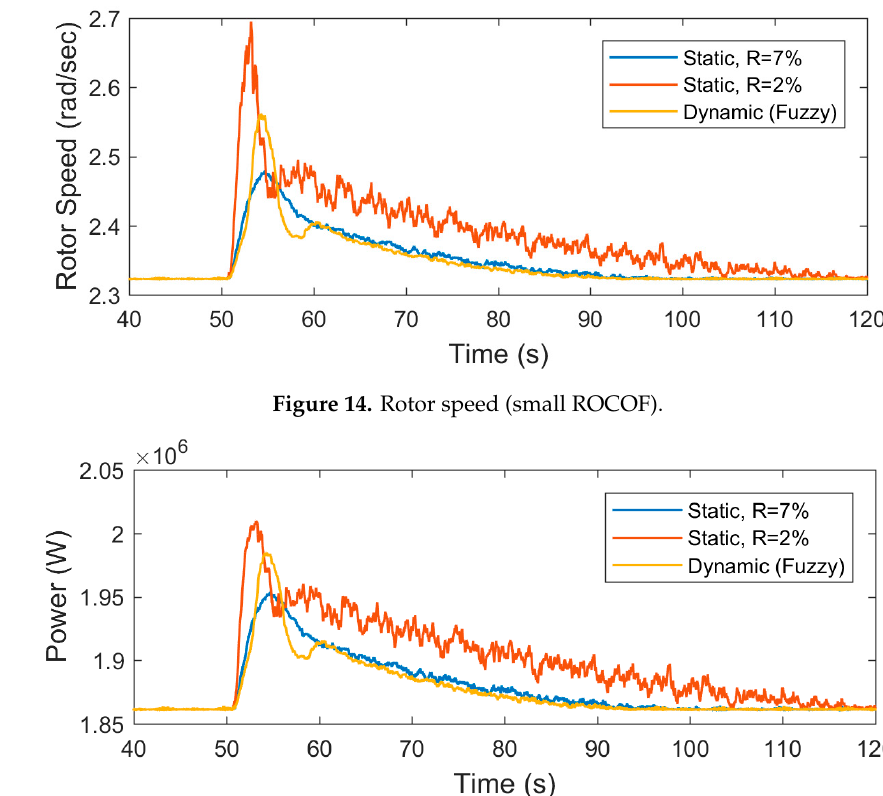
Figure 15. Wind turbine power (small ROCOF).